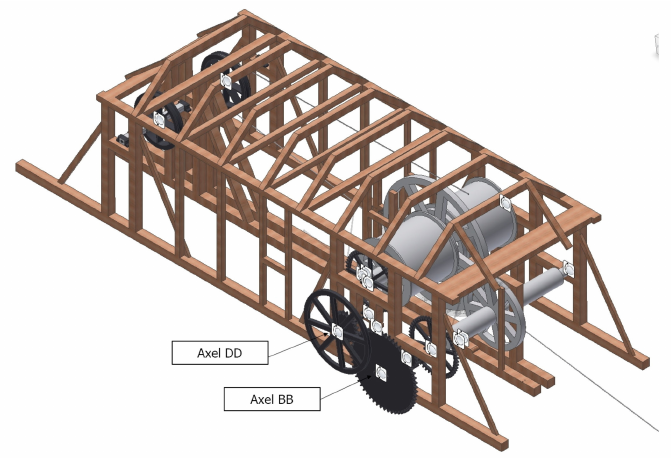
Figure 7. Rotary supports.